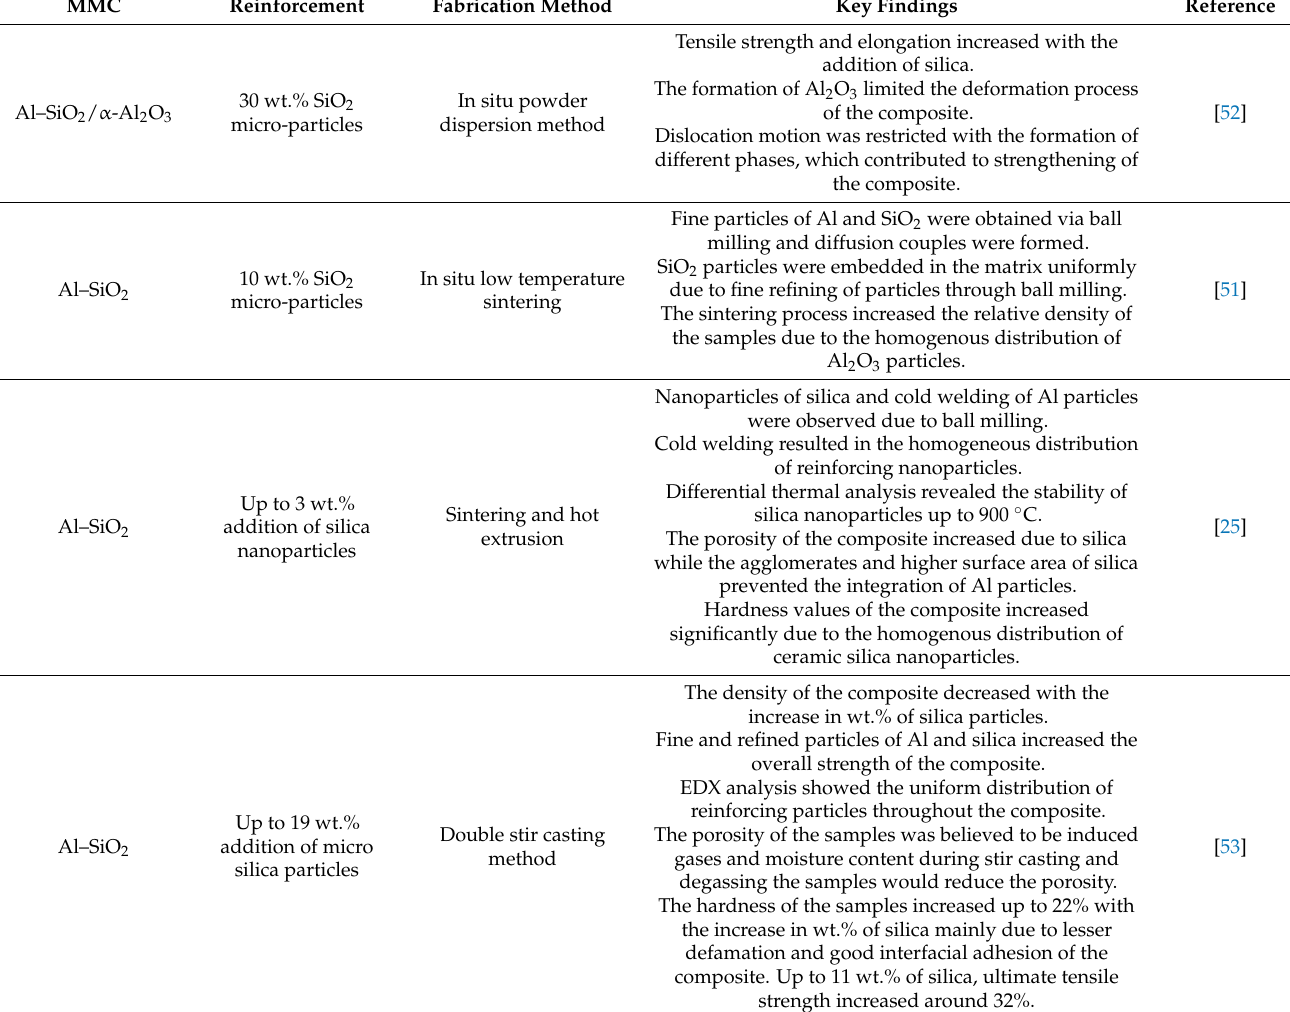
Table 6. The key findings and fabrication methods of silica and Al based